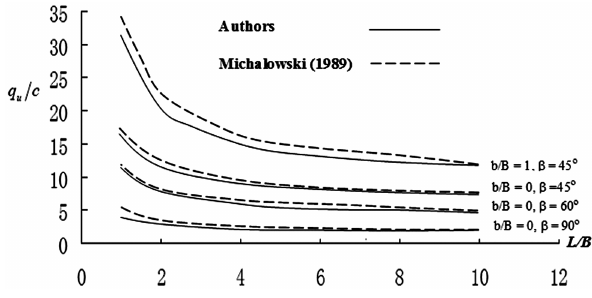
Figure 3. Comparison of present results with upper-bound solutions by Michalowski